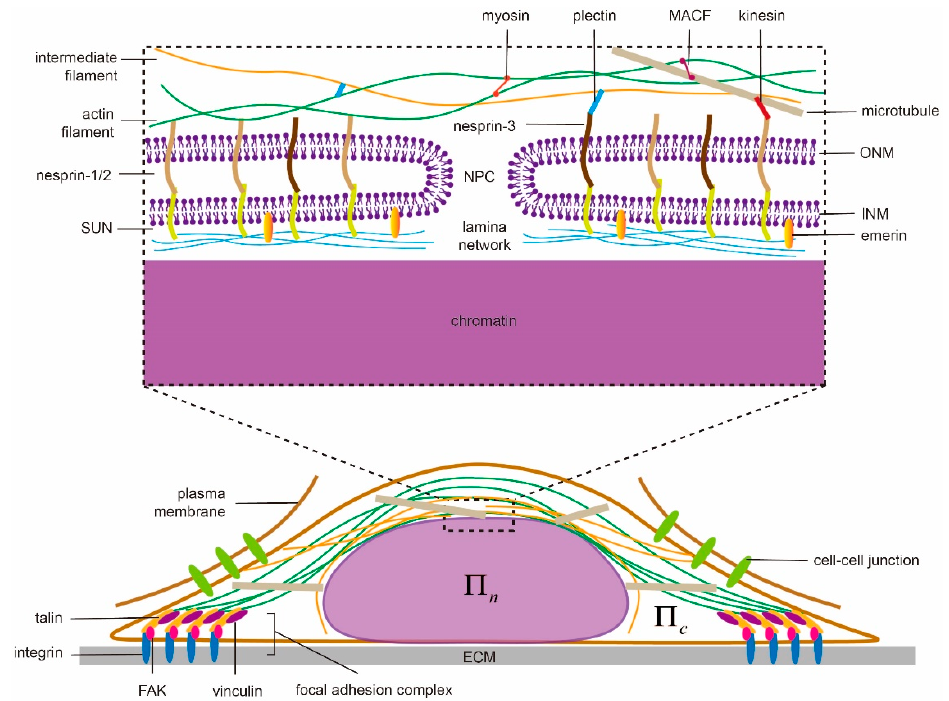
Figure 1. Illustration of biophysical elements regulating nuclear morphology and shape transformation in adherent cells, i.e., nuclear structures and connections, cytoskeleton, extracellular matrix (ECM), cell adhesions and osmolarity. ECM can modulate the nuclear shape through focal adhesions and the associated stressed cytoskeleton with patterns known as perinuclear actin cap and vimentin cage. They transduce inter/intracellular contraction generated by motor proteins to compress the nucleus whose proper functioning largely depends on the linkers of nucleoskeleton and cytoskeleton (LINC) complexes (composed of nesprin family proteins in outer nuclear membrane (ONM) and Sad1/UNC-84 (SUN) proteins in inner nuclear membrane (INM)) and active motor proteins. In addition to chromatin condensation, the integrity of the lamina network layer and its links to INM (via emerin) defines the nuclear deformation ability. Any malfunction of them could lead to abnormal nuclear morphology or failure of shape transformation. In contrast, the osmotic pressure difference between the nucleoplasm ( Π n ) and cytoplasm ( Π c ) could tune the shape by water absorption/leakage without solid